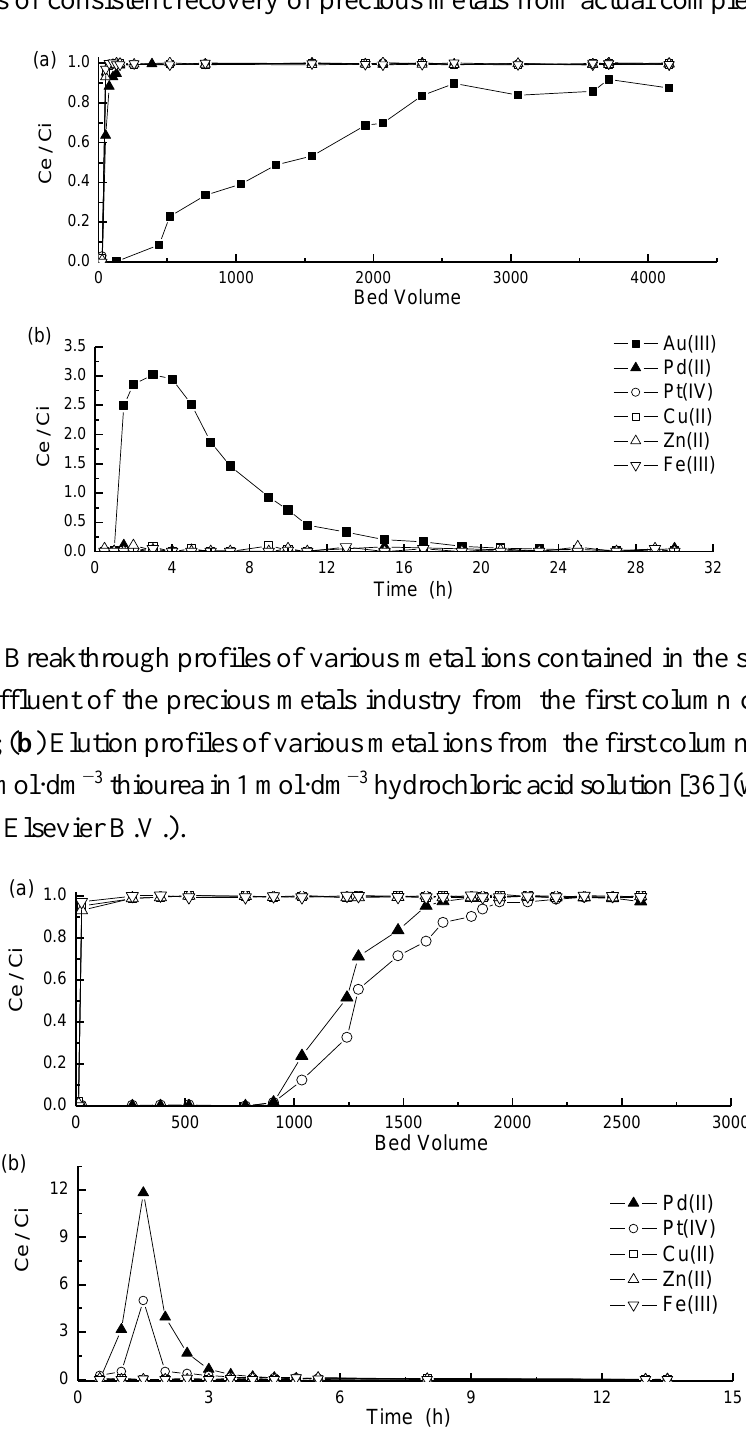
Figure 31. ( a ) Breakthrough profiles of various metal ions from the second column packed with DMA-PW gel; ( b ) Elution profiles of various metal ions from the second column using aqueous mixture of 0.1 mol·dm −3 thiourea in 1 mol·dm −3 hydrochloric acid solution [36] (with permission for reuse from Elsevier